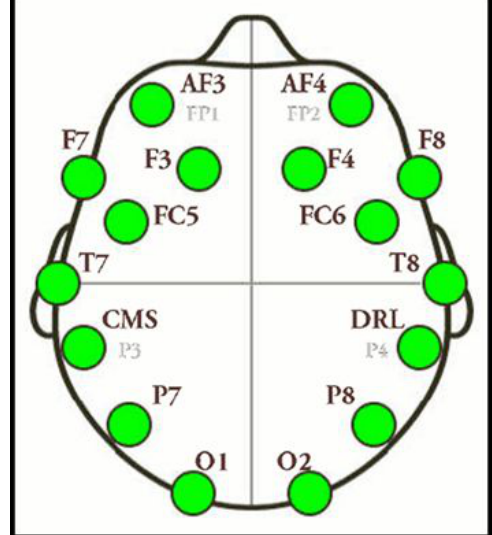
Fig. 2. Figure shows different electrode location on human scalp. The location was divided into four sections which are frontal, tem- poral, parietal and occipital